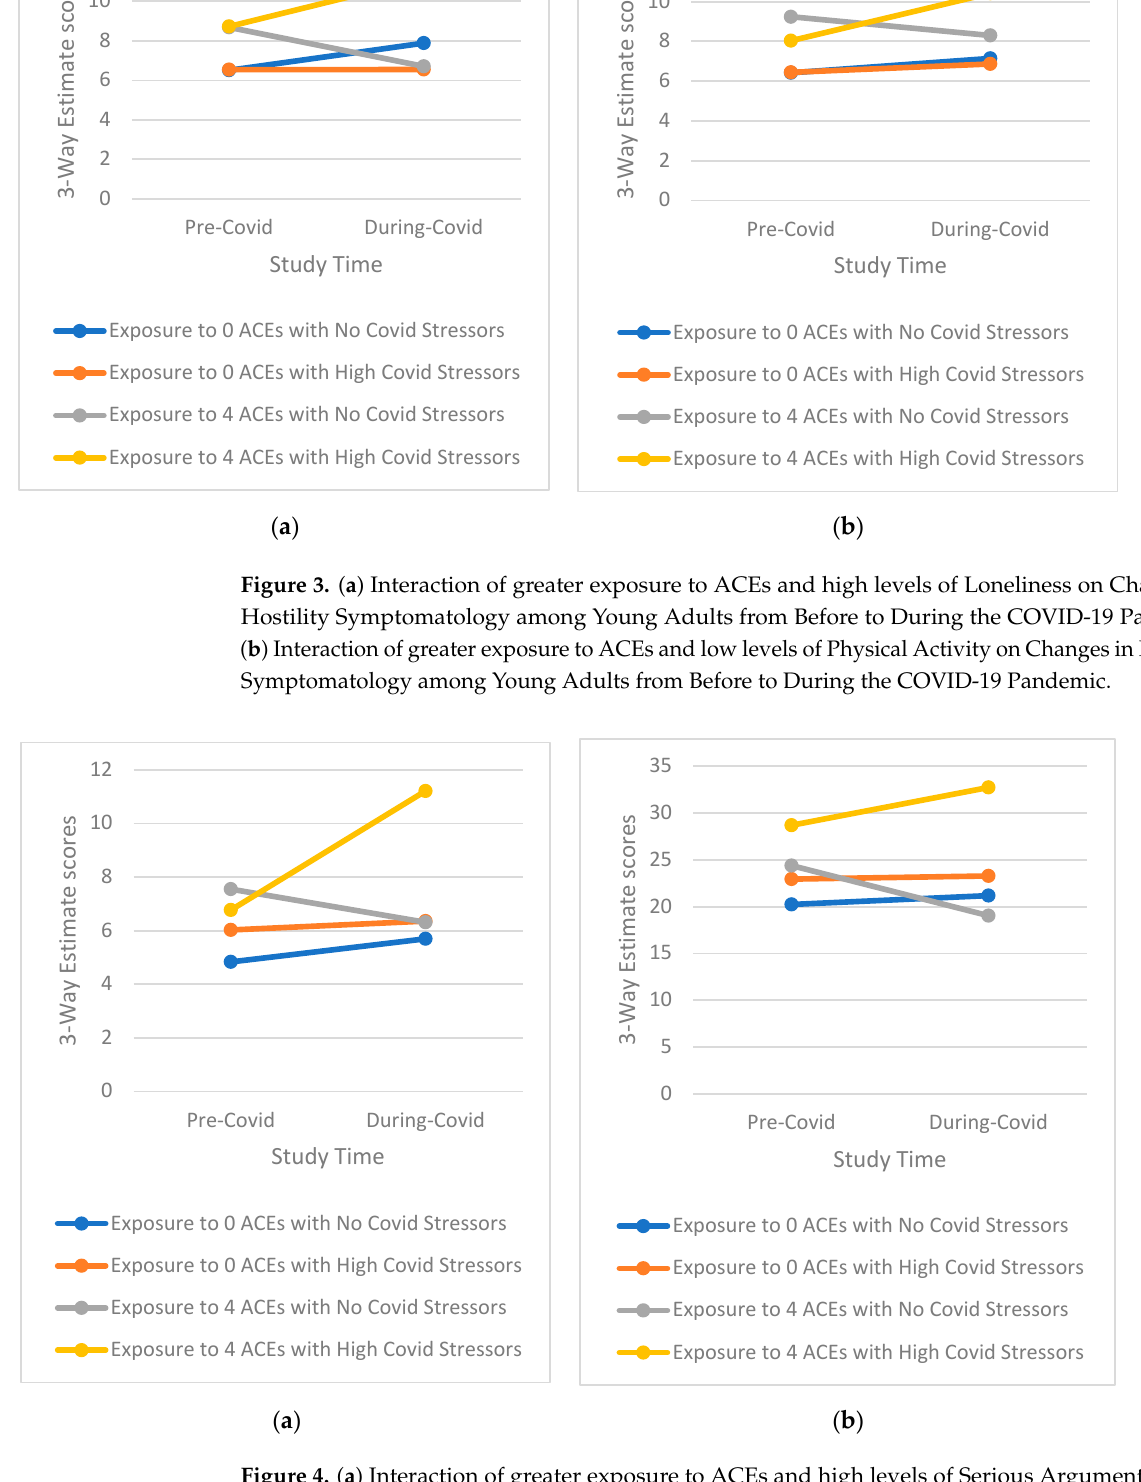
Figure 4. ( a ) Interaction of greater exposure to ACEs and high levels of Serious Arguments with a Roommates on Changes in Hostility Symptomatology among Young Adults from Before to During the COVID-19 Pandemic; ( b ) Interaction of greater exposure to ACEs and high levels of Frustration on Changes in Perceived Stress Symptomatology among Young Adults from Before to During the COVID-19 Pandemic.